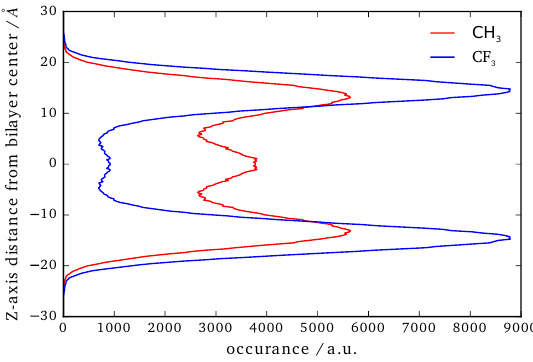
Figure 9. Position of the CF 3 and CH 3 terminal groups along the z -axis relative to the center of mass of the whole